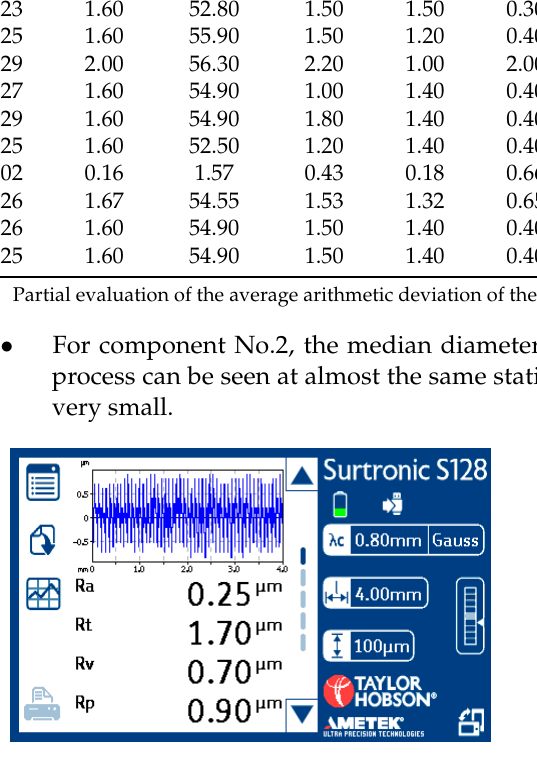
Figure 5. Chart for mode Ra 0.25.